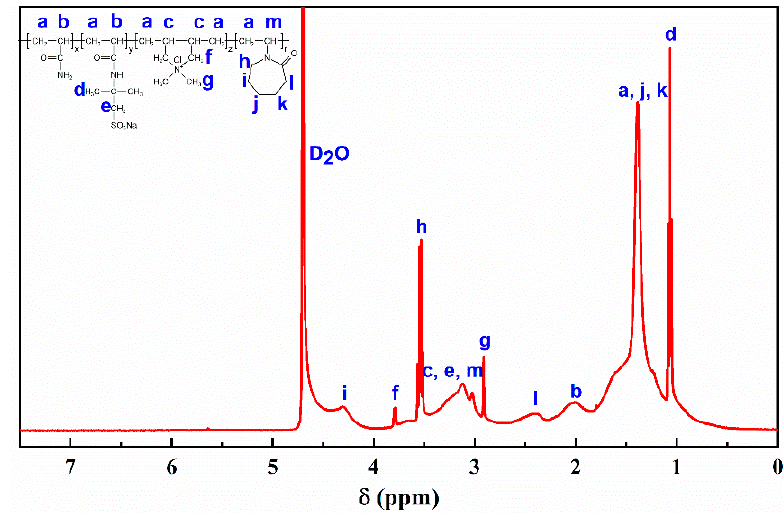
Figure 2. 1 H NMR spectrum of AADN.